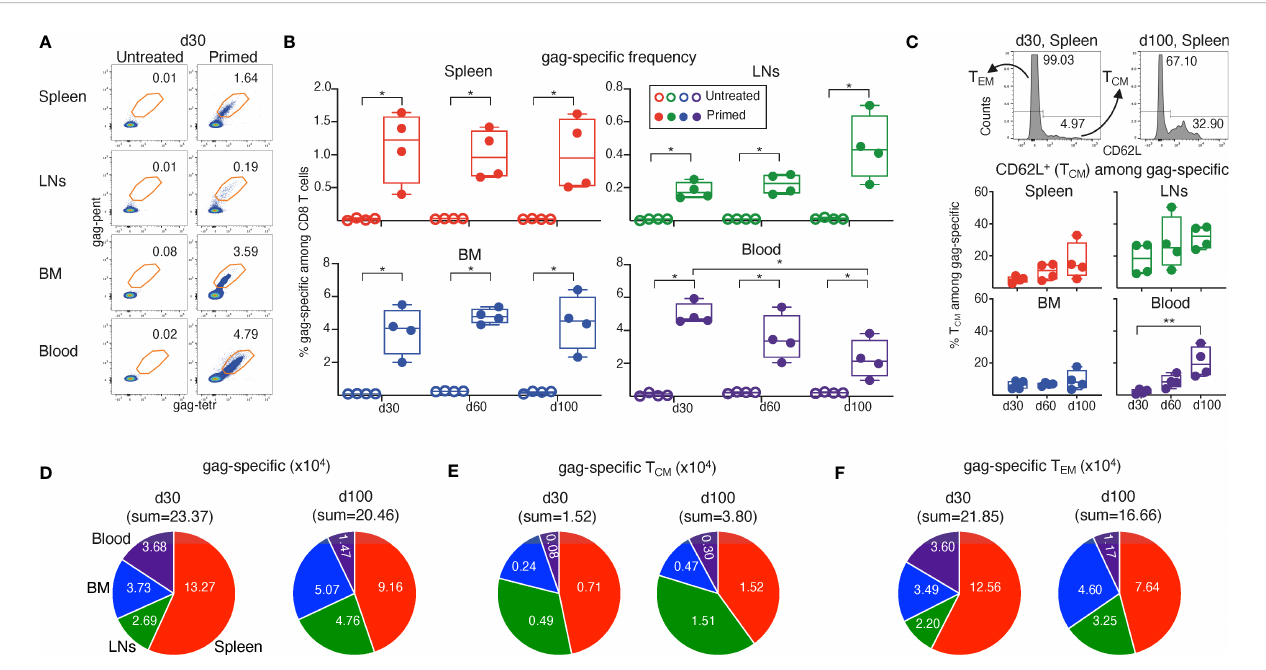
FIGURE 2 Analysis of T CM /T EM -phenotype of gag-speci fi c CD8 T cells from ChAd-gag-primed mice, and estimation of absolute cell numbers. Spleen, lymph nodes (LNs), bone marrow (BM) and blood cells from mice primed as in Figure 1 were analyzed at d30, d60 and d100 post-prime. (A – C) . Flow cytometric analysis was performed after membrane and Ki-67 staining (gating strategy in Figure S3, Ki-67 results in Figure 3). Typical plots showing the percentage of gag-speci fi c CD8 T cells at d30 in untreated (left) and primed (right) mice (A) and summary of results at d30, d60 and d100 (B) . Examples of CD62L histograms of spleen gag-speci fi c CD8 T cells at d30 and d100, showing the gate used to discriminate between TCM (CD62L + ) and TEM (CD62L — ) cells ( C , top). Summary of TCM percentages at d30, d60 and d100 ( C , bottom). (D – F) . Absolute numbers of gag-speci fi c CD8 T cells (D) , and of TCM (E) and TEM (F) gag-speci fi c CD8 T cells, at d30 and d100 in spleen, LNs, BM and blood. The fi gure summarizes results of 4 independent prime experiments with a total of 72 mice analyzed at the indicated d post-prime. In fl ow cytometry plots (in A and C , top), numbers represent percentages of cells in the indicated regions. In panels (B, C) , bottom, each symbol represents a pool of 3 mice. Statistical analysis was performed using Mann-Whitney test for comparison between untreated and primed mice (B) , and Kruskal-Wallis test with Dunn ’ s correction for multiple comparison for comparison among primed mice at d30, d60 and d100 ( B, C, bottom). Statistically signi fi cant differences are indicated (* P ≤ 0.05; ** P ≤